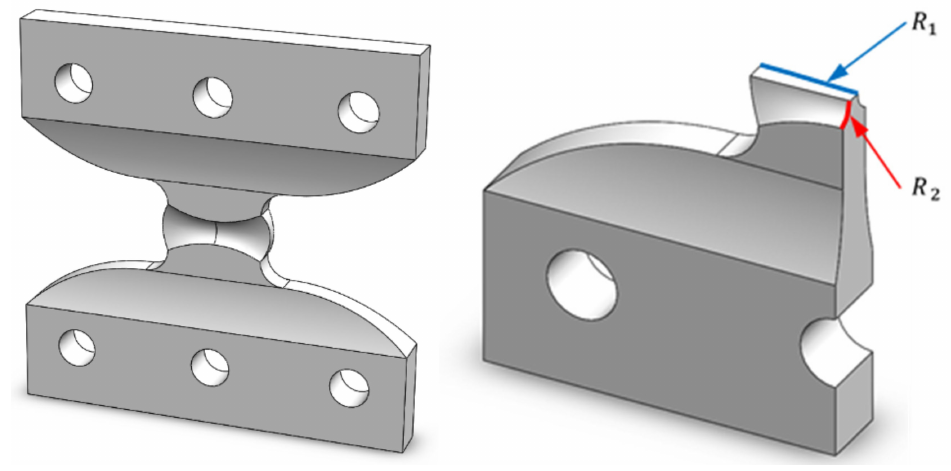
Figure 1. The butterfly